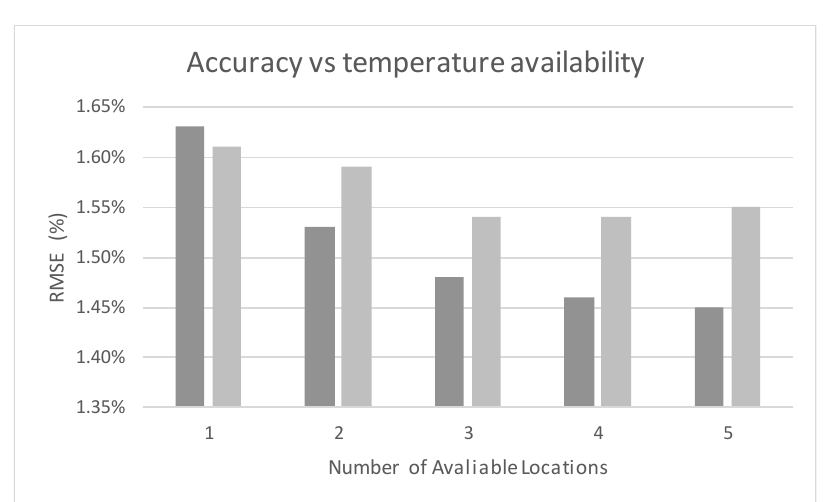
Figure 9. Overall forecasting error (RMSE) with available temperature location from 1 to 5.